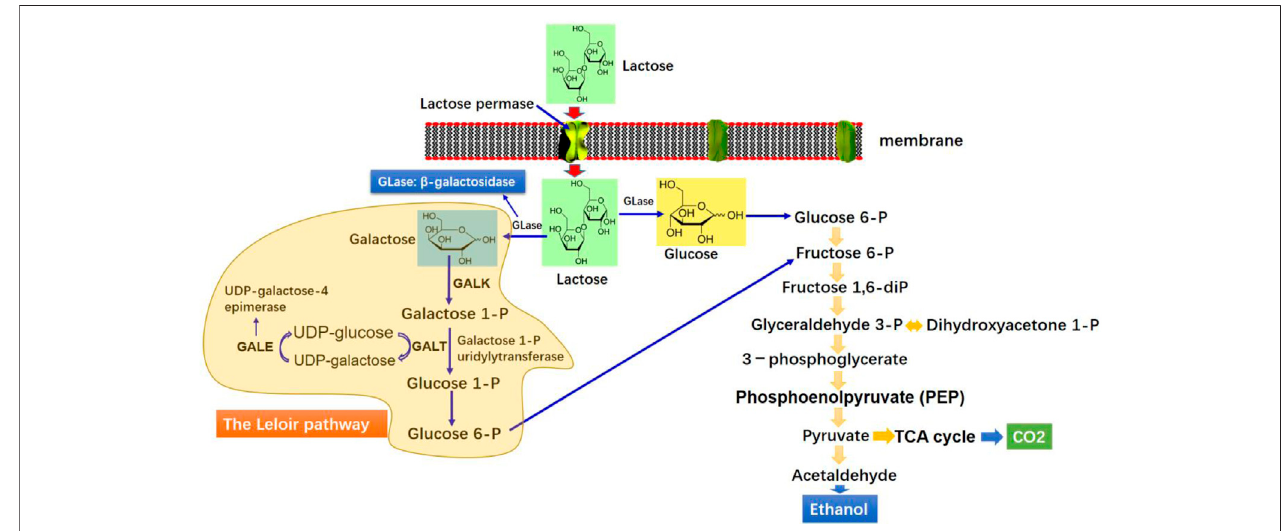
FIGURE 2 | Schematic illustration of the catabolic pathway of lactose and ethanol production by K. marxianus .